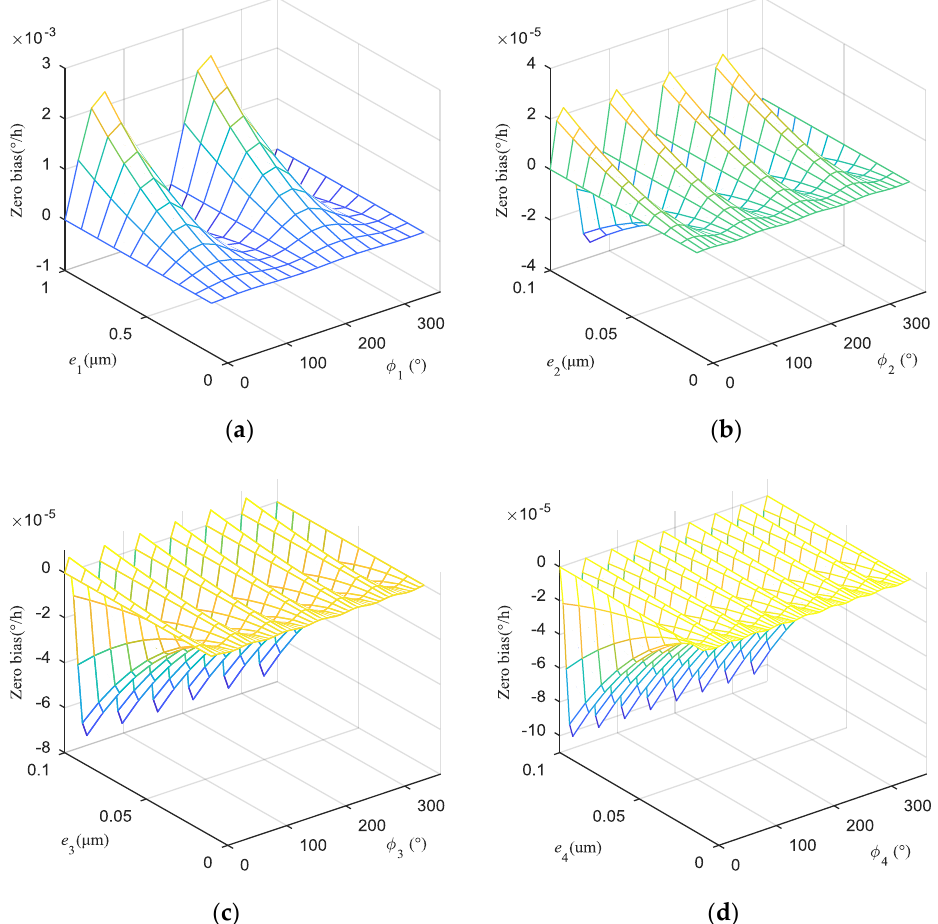
Figure 6. The zero biases caused by the first four harmonics of uneven capacitance gap are respectively: ( a ) Zero bias caused by the first harmonic; ( b ) Zero bias caused by the second harmonic; ( c ) Zero bias caused by the third harmonic; ( d ) Zero bias caused by the fourth harmonic.